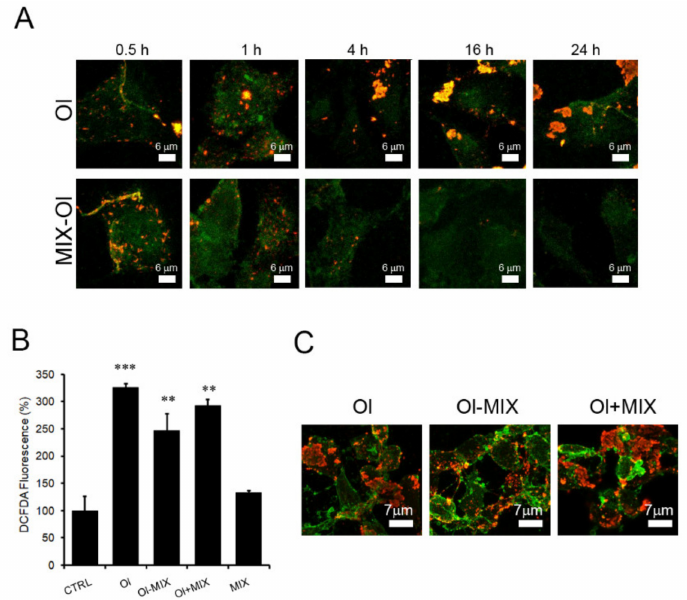
Figure 4. The MIX does not alleviate aggregate-impaired autophagy. Aggregate-GM1 co-localization and ROS levels in SH-SY5Y cells treated with oligomers (2.5 µ M, monomer concentration) for different times (0.5 h to 24 h) in absence or in presence of a 24 h pre-treatment with MIX. ( A,C ) Immunolocalization of A β 1–42 oligomers on the plasma membrane by confocal microscopy. Cells were stained with Alexa 488-conjugated CTX-B (green fluorescence); A β 1–42 oligomers were stained with anti- A β 1–42 antibodies and with Alexa 568-conjugated anti-rabbit secondary antibodies (red fluorescence). ( B ) intracellular ROS levels were detected by CH2-DCFDA probe in SH-SY5Y cells exposed to oligomers (2.5 µ M) for 24 h followed by treatment with the MIX for further 24 h (Ol-MIX), or co-treated for 24 h with the MIX and A β 1–42 oligomers (Ol+MIX DCFDA fluorescence are reported as percentage respect to untreated control cells. Error bars refer to the standard errors of at least three independent experiments. **: p -value < 0.01; ***: p -value < 0.001 vs. untreated control